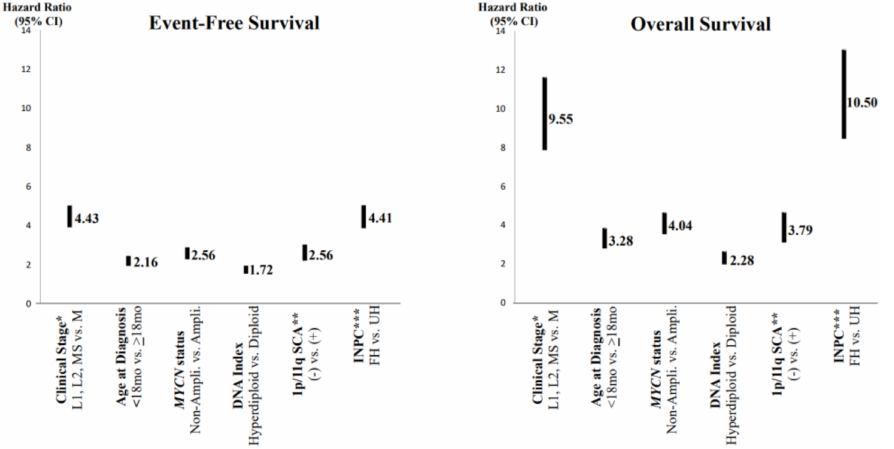
Figure 1. Neuroblastoma, prognostic factors and hazard ratios. * Clinical stage according to the International Neuroblastoma Risk Group Staging System; ** SCA = segmental chromosomal aberra- tions; *** INPC = International Neuroblastoma Pathology Classification (FH = favorable histology, UH = unfavorable histology). Note: Clinical stage (localized (L1 and L1) and MS (metastatic, special) disease vs. M (metastatic) disease) and INPC (FH group vs. UH group) distinguish tow prognostic groups with very high hazard